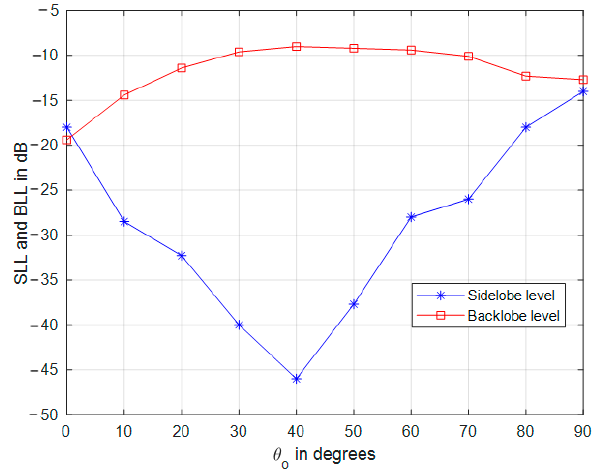
Figure 14. Sidelobe and backlobe variation with the mainlobe direction.